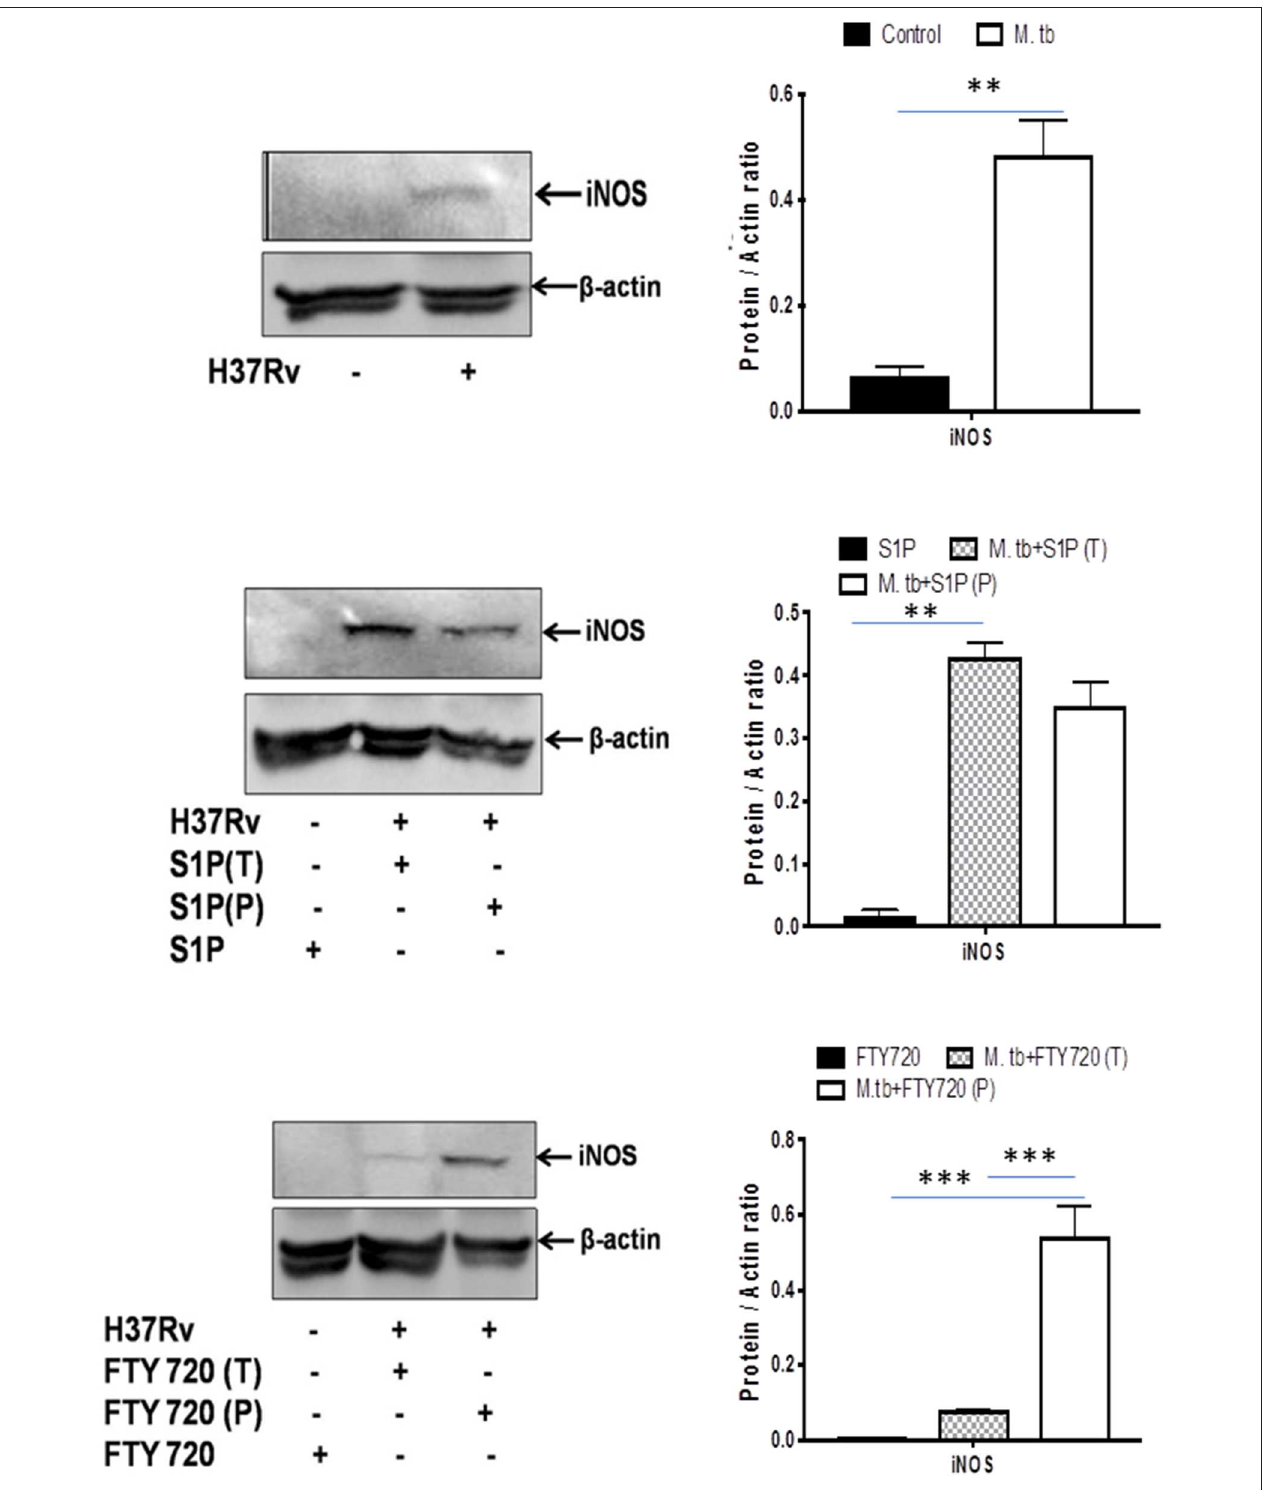
FIGURE 9 | Sphingolipids promote M1 programming in the lung during the course of M. tuberculosis infection. M. tubeculosis –infected mice were conditioned with indicated sphingolipid drug derivatives, and whole lung lysates from these mice were purified and analyzed for M1 effector protein (iNOS) by Western blot. Shown here are the representative blots from each group. β -actin was used as a loading control. Densitometric analysis of the blot shown was quantified by ImageJ software, and the values were plotted in terms of relative protein expression. Statistical analyses were conducted using two-way ANOVA followed by Bonferroni posttest (** P < 0.01, *** P <